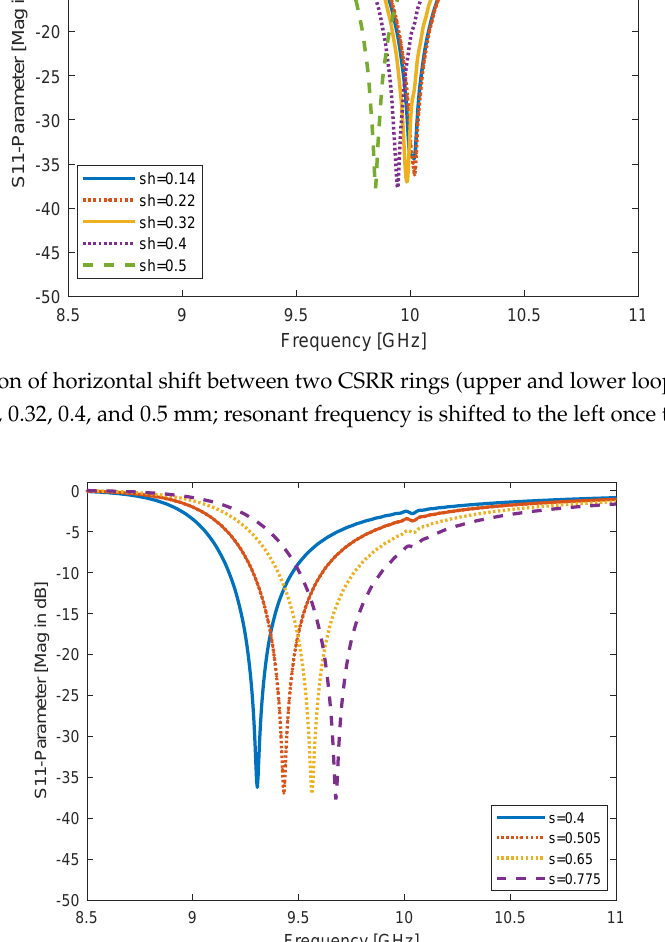
Figure 7. Engraving the center width of both CSRR rings, the s parameter for both loops and its changing s = 0.4, 0.505, 0.65, and 0.775 mm; the resonant frequency is shifted to the right as a result of changing